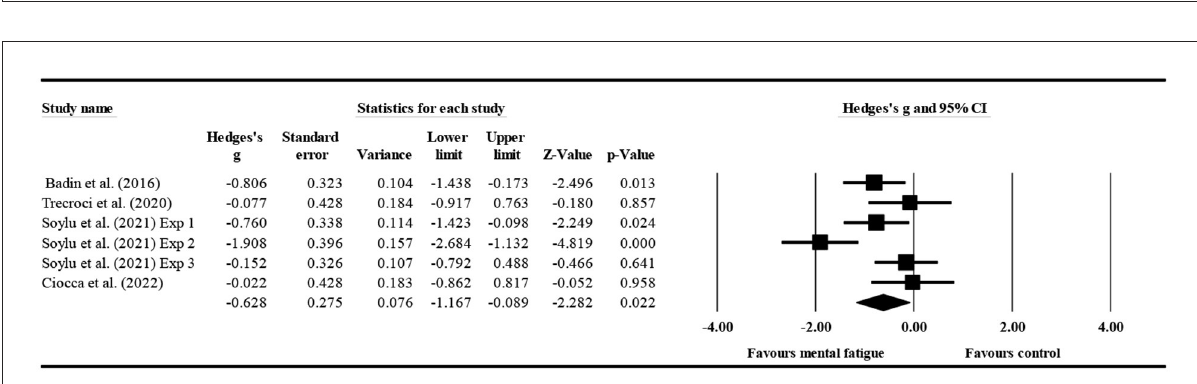
might put in less effort and select a more conservative